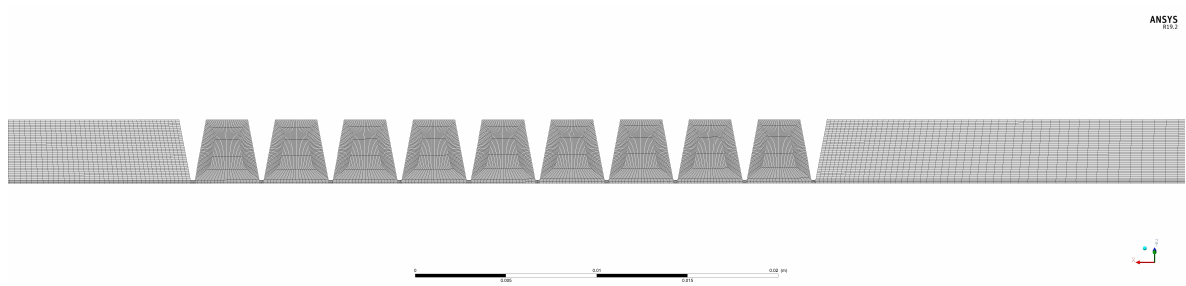
Figure 4. Meshing diagram of +y+z 45 degrees panel.